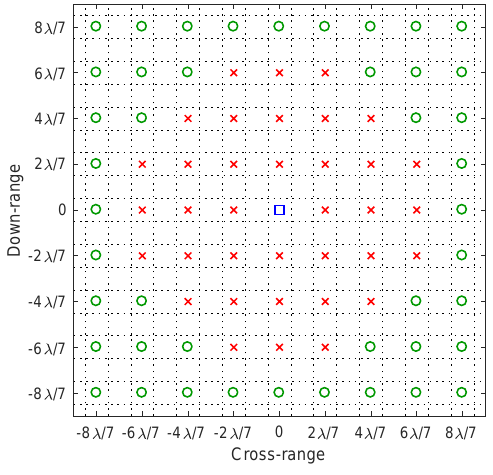
Figure 9. Result of the separation test: (cid:3) —the fixed location of the first scatterer, × —the tested location of the second scatterer for which the two scatterers are not separable, ◦ —the tested location of the second scatterer for which the two scatterers are separable. Dictionary grid points are located at intersections of dotted lines. Note that the coordinate origin in this plot is shifted to the location of the first scatterer. Identical results are obtained when the first scatterer is placed at the radial distance of 0.3 m or 0.6 m from the rotation